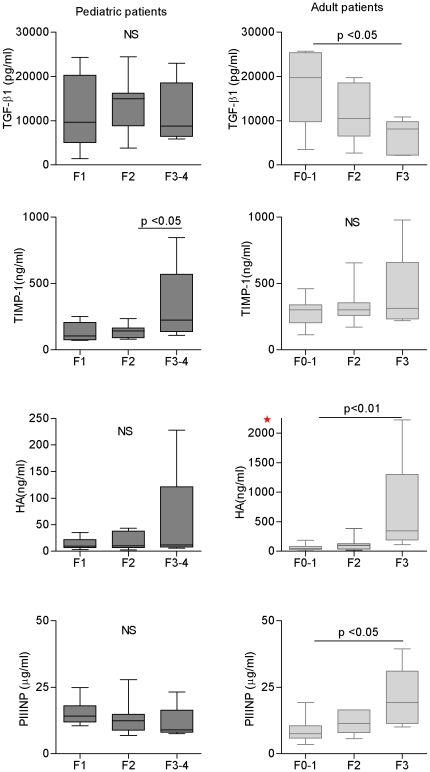
Serum markers related to fibrosis stages in chronic hepatitis C patients.A) TGF-ß1, B) TIMP-1, C) HA, D) PIIINP. Horizontal lines inside each box represent the median, and the lower and upper borders of the box encompass the interquartile range. The vertical lines from the ends of each box encompass the extreme data points. Fibrosis stages according to METAVIR. NS: no significant. * Note: different scale compared with pediatric values.